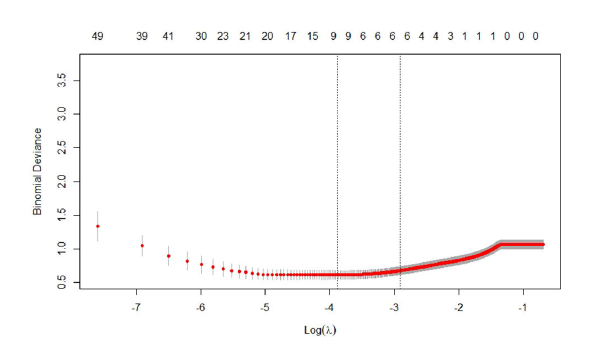
FIGURE 3 Selection of texture features by the least absolute shrinkage and selection operator (LASSO) regression in the training